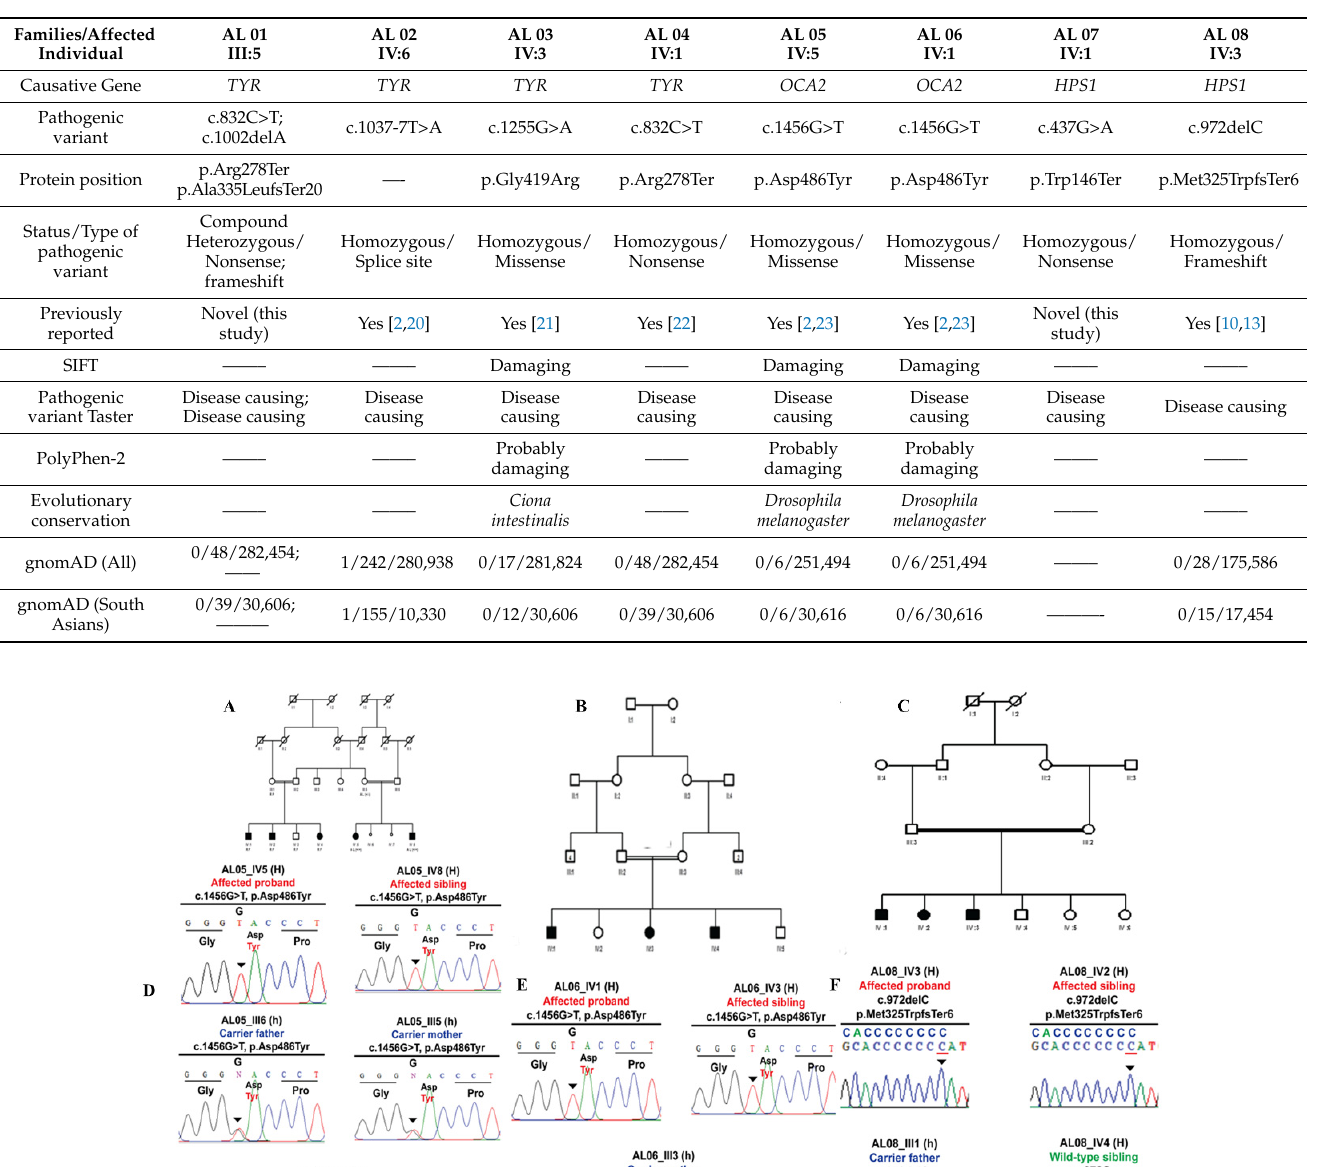
Table 2. Novel and reported TYR , OCA2 and HPS-1 variants identified in albinism families in this